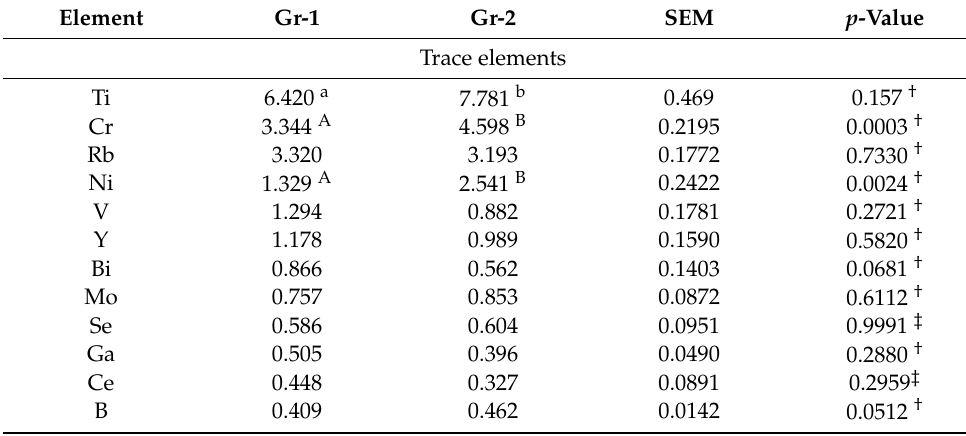
Table 4. The concentrations of trace and ultratrace elements in the feed mixture